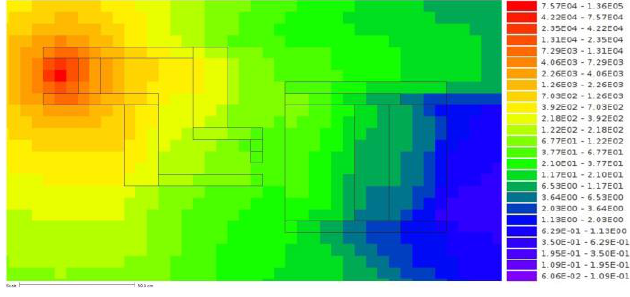
Fig. 7. Total photon flux - SCALE [par.cm -2 .s -1 ]